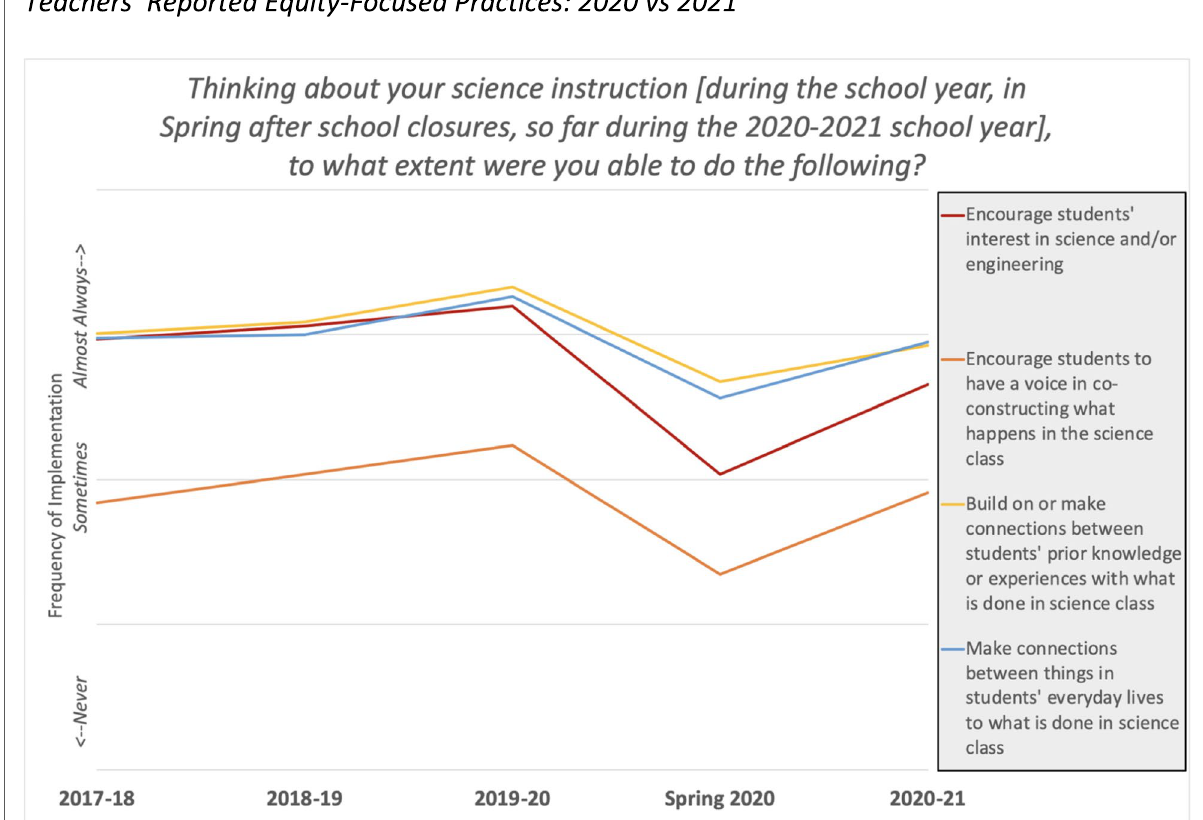
Fig. 4 Teachers’ Reported Equity-Focused Practices: 2020 vs